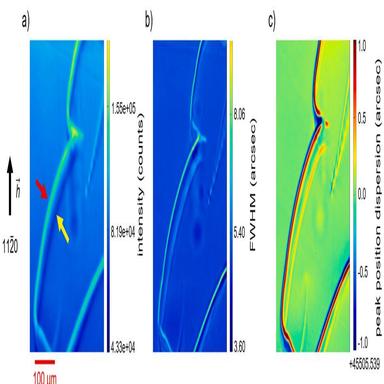
a) integrated intensity map b) FWHM map and c) peak position map of an AlN crystal displaying dislocations (1120 reflection, 20 keV). The dislocation images exhibit a typical behaviour (see text) that constitutes a kind of "signature" of these linear defects.